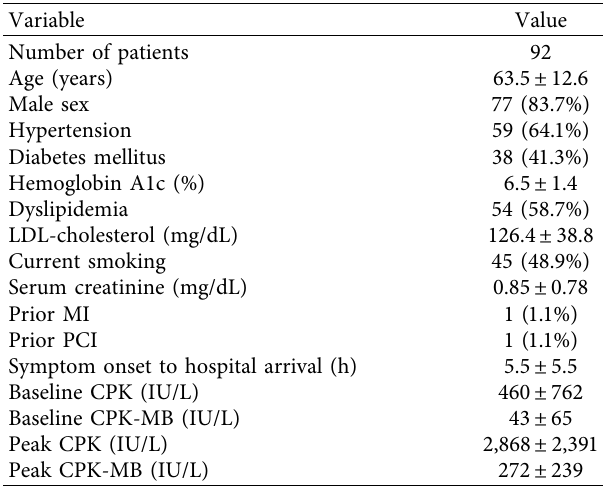
Figure 1: Study flow chart. ELCA, excimer laser coronary angioplasty; MT, manual aspiration thrombectomy; OCT, optical coherence tomography; and STEMI, ST-segment elevation myocardial infarction. Table 1: Patient